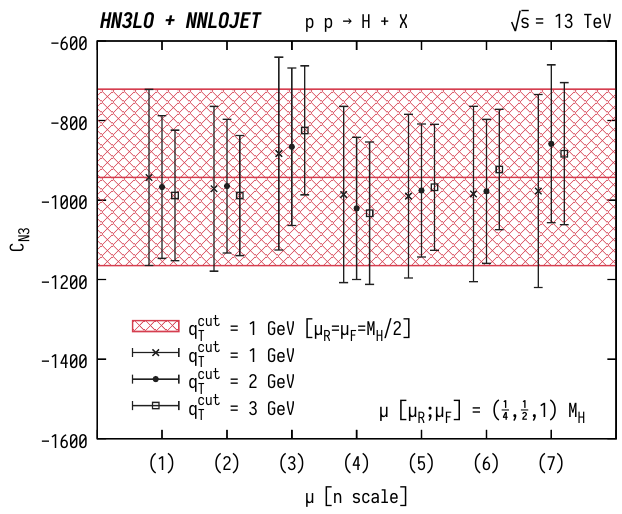
Figure 2 . The numerically extracted C N 3 coe(cid:14)cient (for three di(cid:11)erent values of q cut of the combination of scales, as enumerated in table 1. The error bars for each particular C N 3 point are obtained propagating the statistical uncertainties of the di(cid:11)erent terms involved in the computation. The red band corresponds to our best estimation for C N 3 obtained with the central scale (cid:22) = M H = 2 at q cut = 1 GeV, as detailed in the text. T